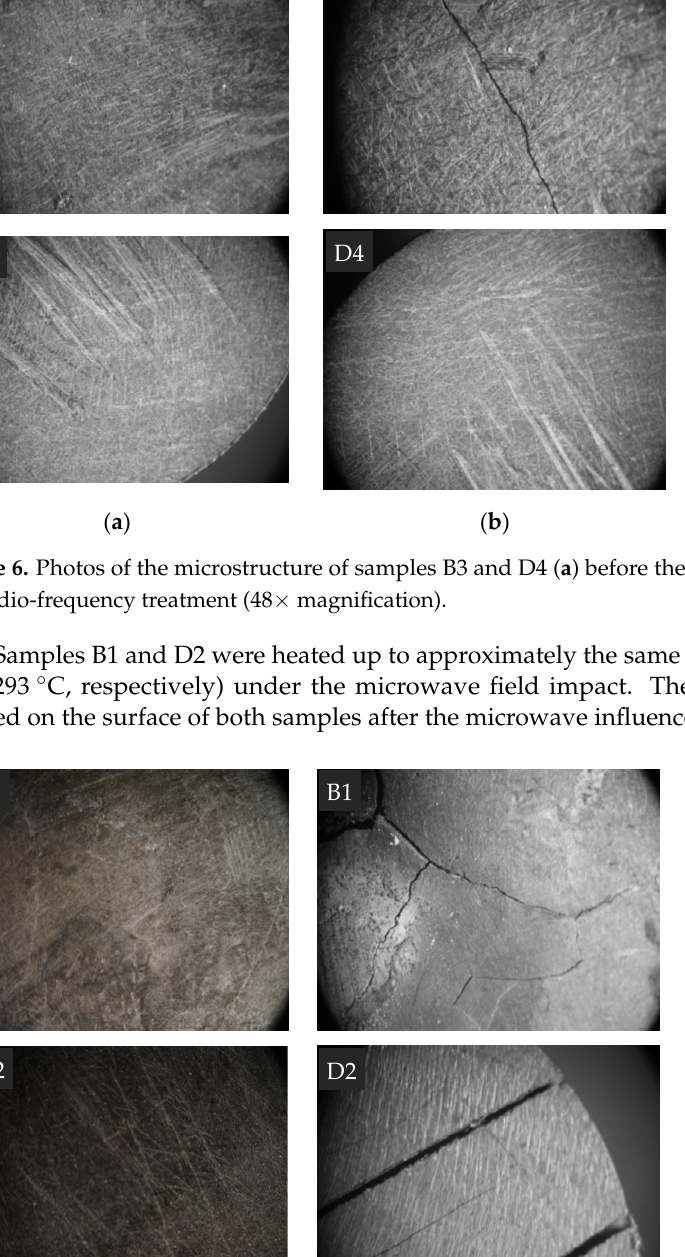
( c ) Figure 8. Photos of the microstructure of the Bazhenov Formation sample B5 ( a ) before the treatment; ( b ) after the micro- wave treatment; and ( c ) after the radio-frequency treatment (48× magnification). The fractures on the sample were recorded as early as 10 s after the onset of micro- wave exposure when the sample temperature exceeded 50 ° С . Intensive growth of frac- tures was observed within 40 s. During this time, the sample was heated up to 140 ° С . Further microwave treatment did not change the structure of the sample surface. The for- mation of new fractures apparently occurred in the volume of the sample. The final con- figuration of fractures is shown in Figure 8b. Scanning electron microscope images of the surface of several samples after electro- magnetic treatment are shown on Figure 9. A number of intense microfractures oriented along the lamination were found in sample B1. It is obvious since the sample has a thin layered microstructure formed by clay minerals as well as thin organic matter lenses which are 1–10 µm thick and 5–50 µm long. The other samples have a massive structure and do not have such inhomogeneity except for sample D3. The thin layering in sample D3 is caused by elongated calcite detritus 10–50 µm in thickness and often more than 100 µm in length. However, there were not cracks in the sample.